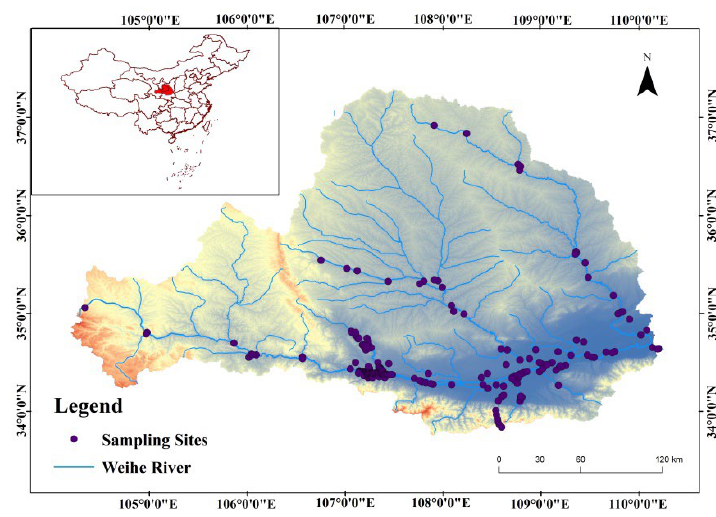
Figure 1. Location of the study area.